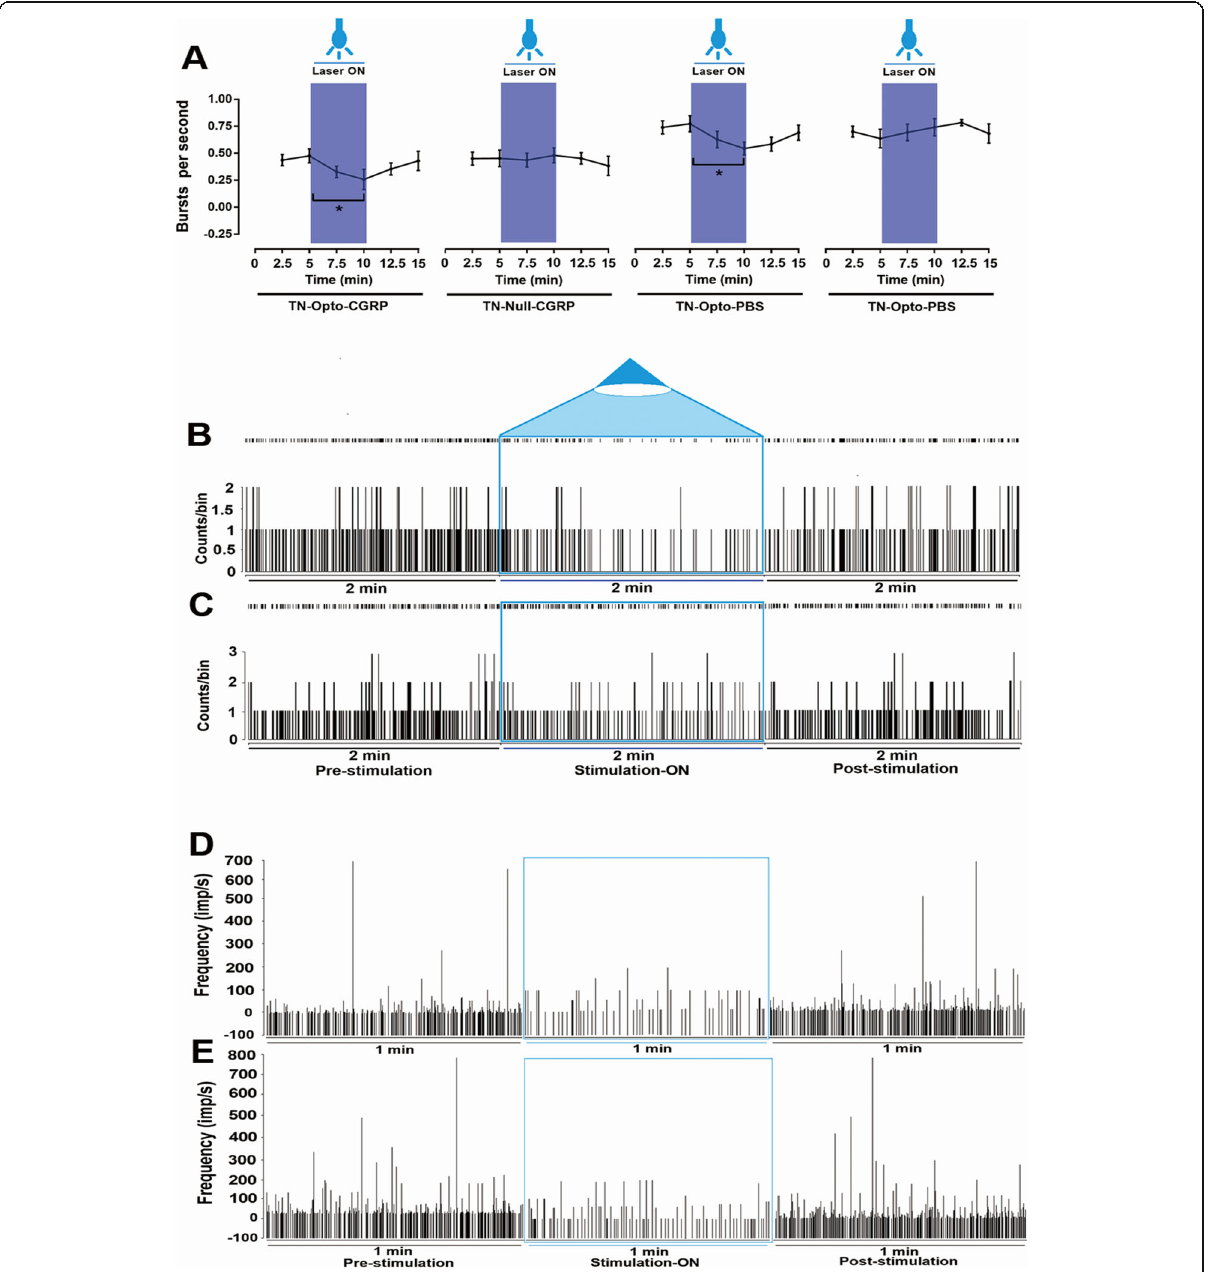
Fig. 6 Burst firing rates in TN animals following optogenetic stimulation ( a ). Significant changes were observed in the TN-Opto-CGRP and TN- Opto-PBS groups. *, p < 0.05; **, analysis of variance (ANOVA). b , c Peri-event raster histogram of VPM neuron responses in the TN-Opto-CGRP and TN-Opto-PBS groups, respectively. VPM firing rates decreases during optical stimulation. Bin size = 50 ms. d , e Instantaneous firing frequency for VPM neurons in TN-Opto-CGRP and TN-Opto-PBS rats,